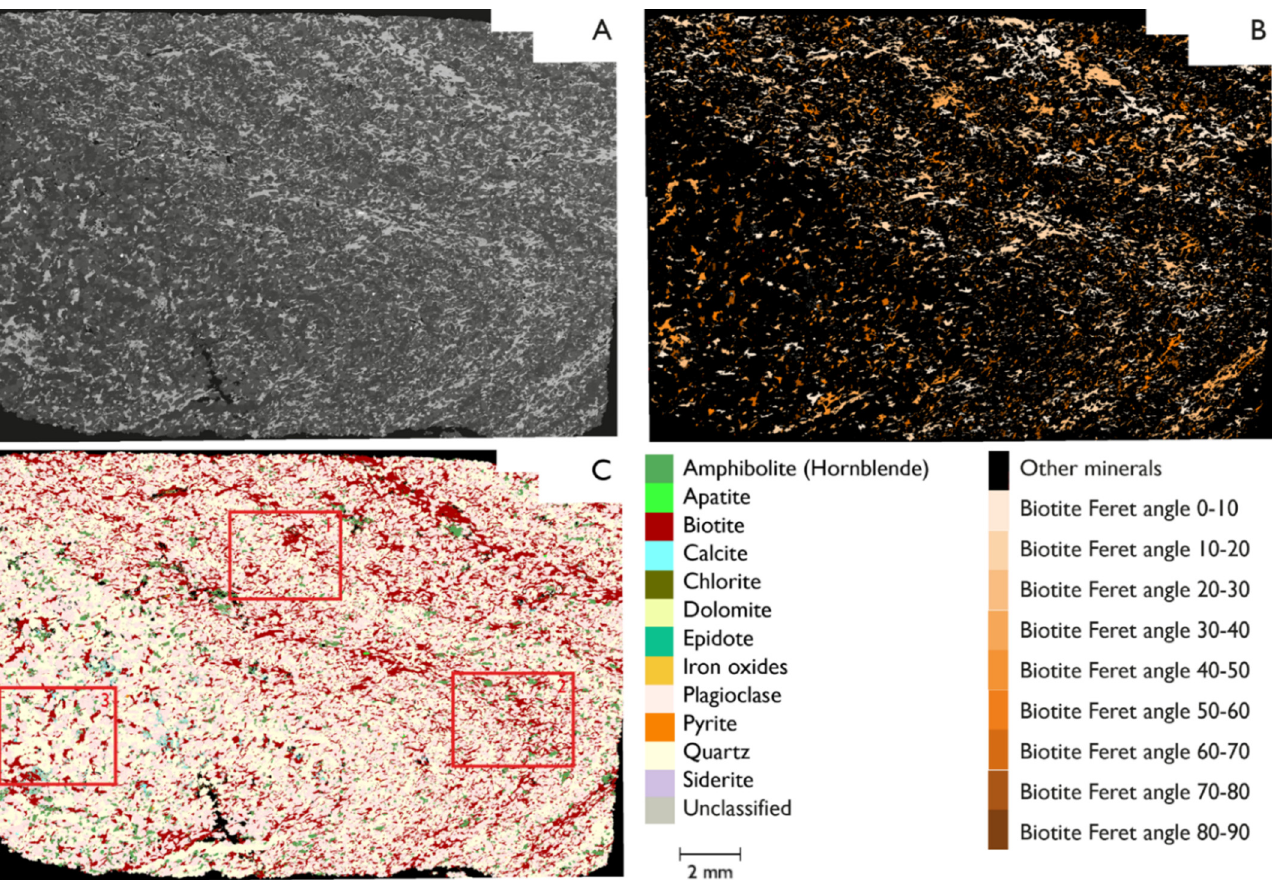
Figure 12. Isoclinal fold in a volcanoclastic sediment containing biotite, amphibole, anorthite and quartz. ( A ) BSE micrograph of the sample. The three main phases (biotite, anorthite and quartz) are light, intermediate and dark grey respectively. ( B ) Maximum Feret angle map over the thin section. All none-biotite minerals are black, while biotite is coloured by its maximum Feret angle. Positive and negative angles are indicated in the same colours. ( C ) Mineral map showing the distribution of the mineral phases in the sample. This mineral map contains 2.04 million pixels. Squares define three smaller areas within the sample, with their own data for surface area and association data.